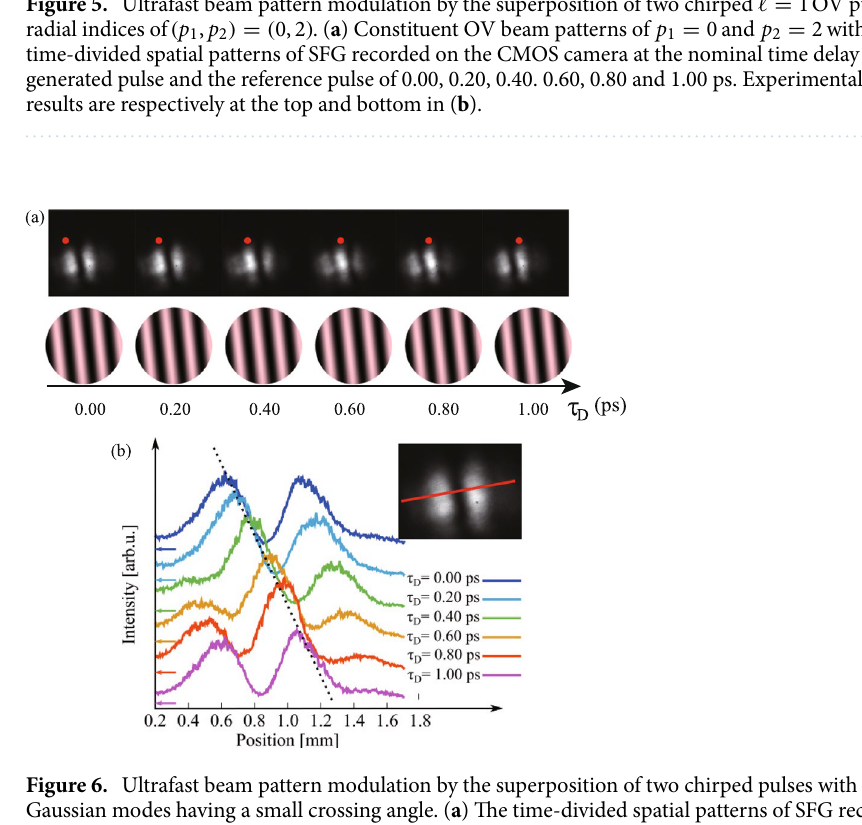
1 OV pulses with the = 1 . ( b ) The 0 and p 2 2 with ℓ = = =